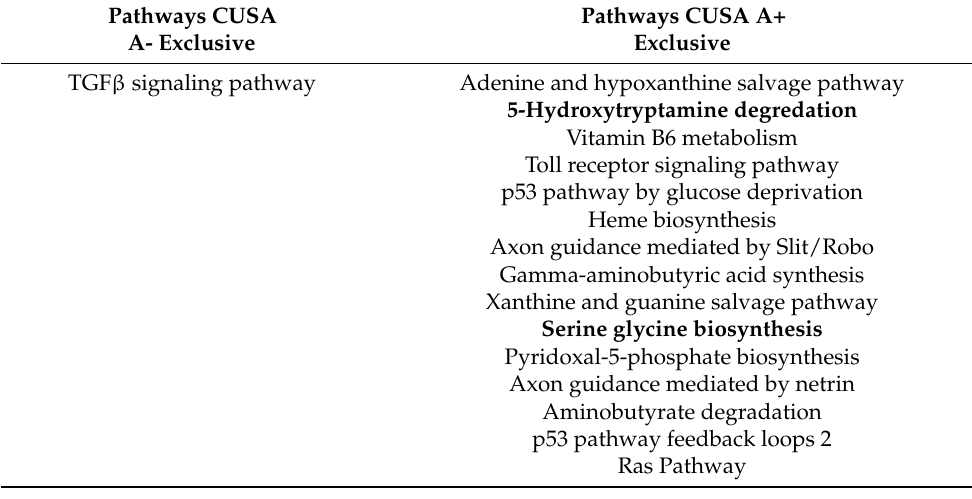
Figure 7. Venn diagram of molecular pathways from the three complete zones. The 32 molecular pathways classified considering the CUSA CORE proteins, were all shared by CUSA A+ and CUSA A- pathways classification, hence, CUSA CORE did not exhibit exclusive pathways. Table 5 lists the molecular pathways exclusively classified in CUSA A+ and CUSA A-. Table 5. Molecular pathways exclusively classified in CUSA A- and CUSA A+. The pathways in bold were found over-represented by Panther tool following the gene ontology analysis of 193 proteins grouped as “tumor